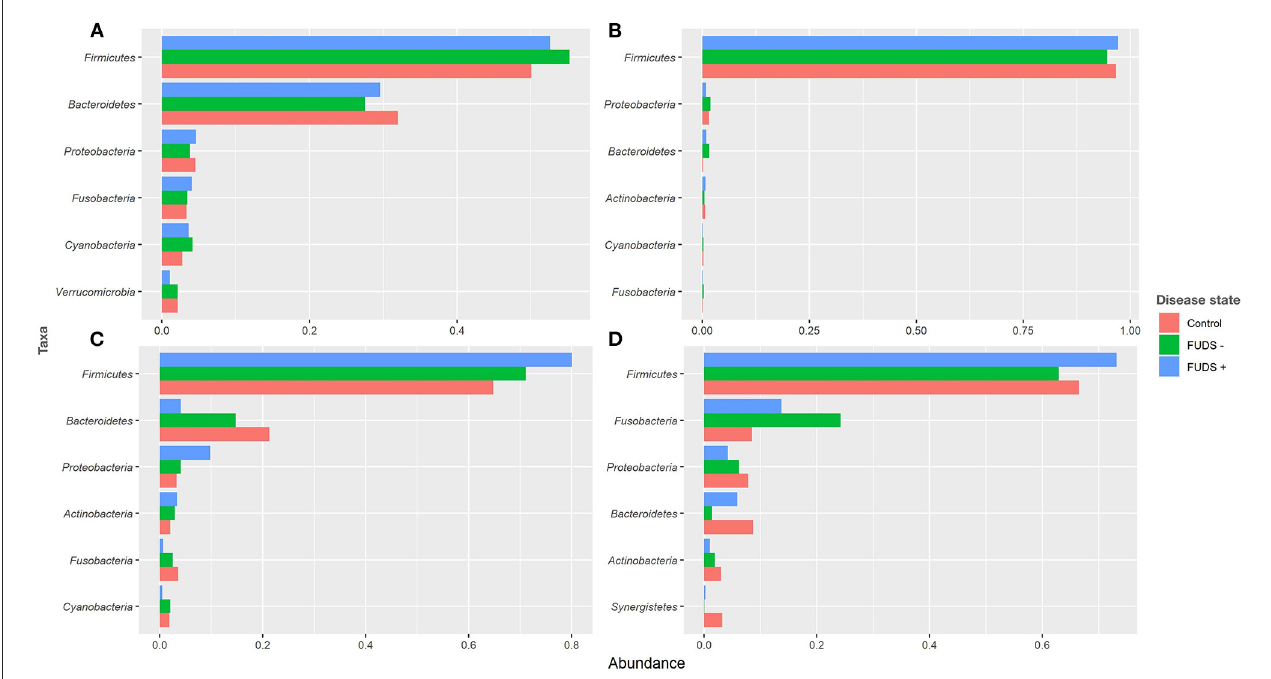
FIGURE3 Relative abundance plot of top six taxa at phylum level for Control, FUDS –, and FUDS + flocks by sample type. (A) Cecum; (B) ileum; (C) skin; and (D) cloaca.